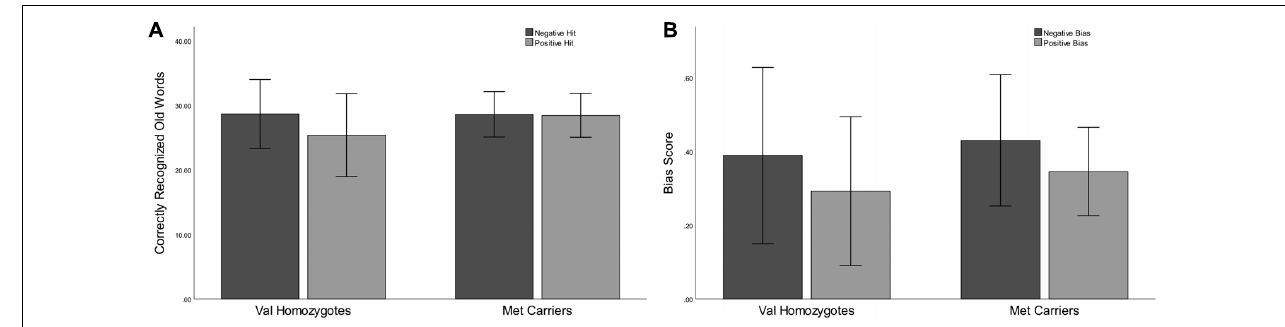
FIGURE 3 | Experiment 2: Mean recognition accuracy as a function of valence for Val homozygotes (left within graph) and Met carriers (right within graph) (A) . Mean bias score as a function of valence for Val homozygotes (left within graph) and Met carriers (right within graph) (B) . Error bars show 1 standard deviation of the mean.